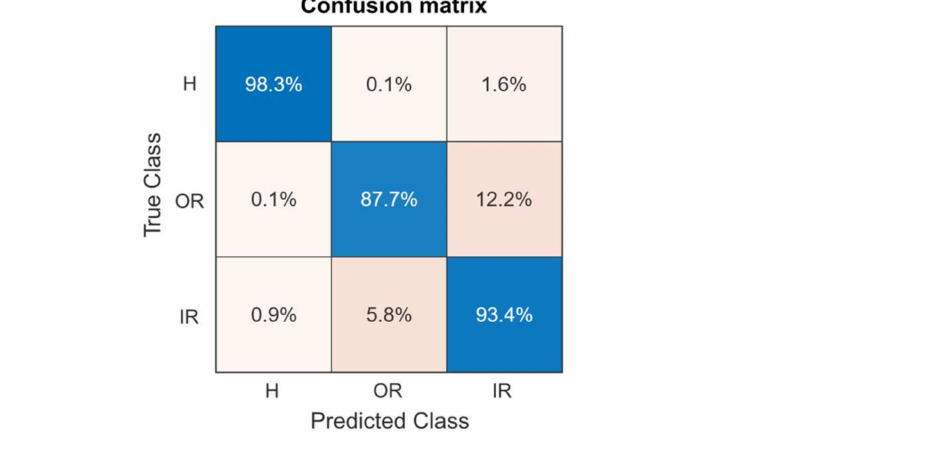
Figure 17. The confusion matrix was obtained using the results achieved by the proposed